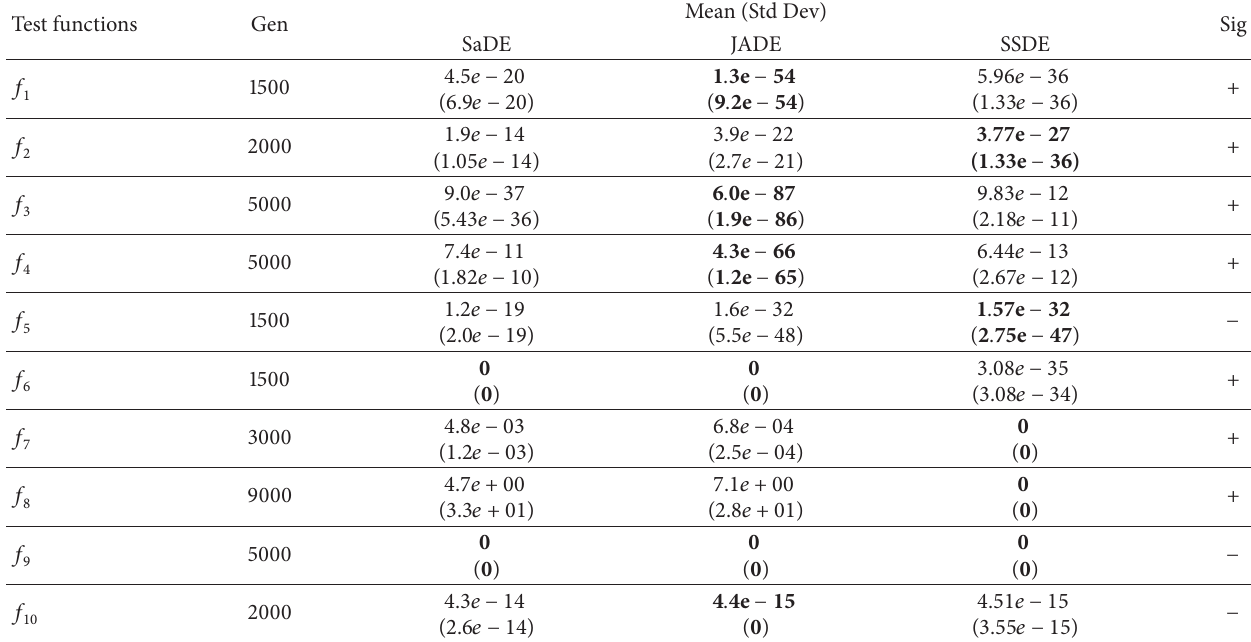
Table 4: Comparison results between SSDE and the other state-of-the-art algorithms. Test functions